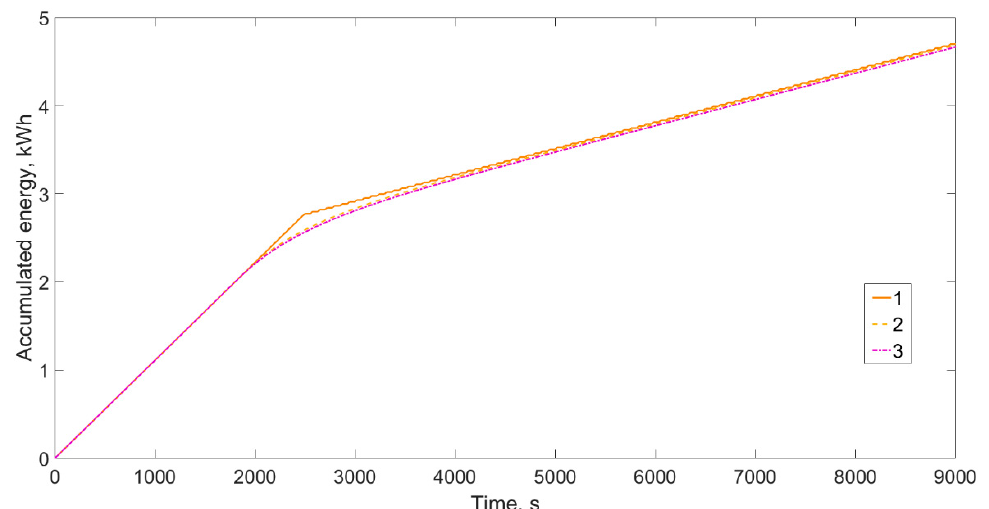
Figure 13. Course of cumulative energy usage for control systems with the controllers (no noise): 1—relay and 2—PID, 3—I-PD.